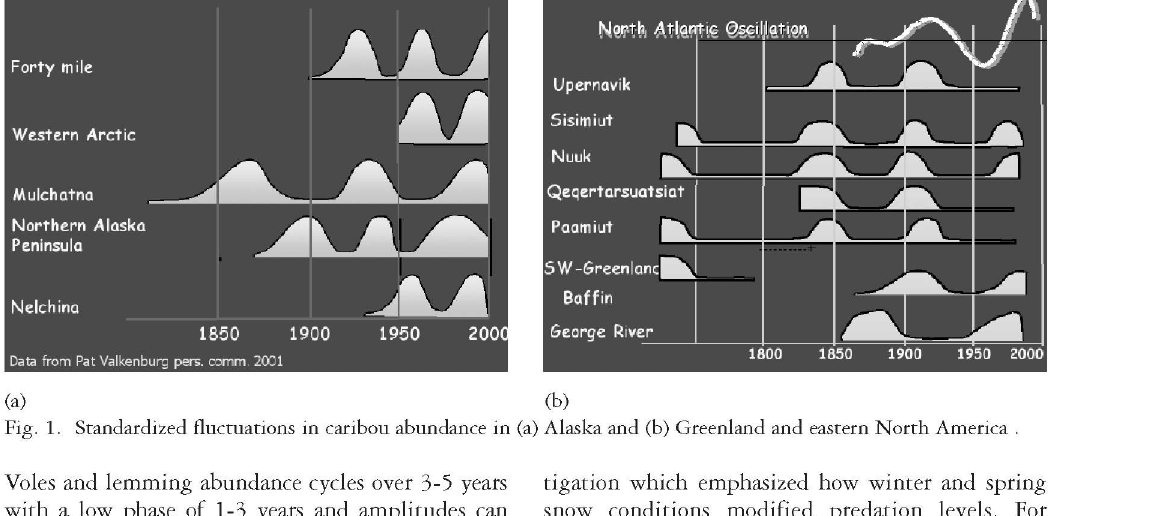
Fig. 1. Standardized fluctuations in caribou abundance in Voles and lemming abundance cycles over 3-5 years with a low phase of 1-3 years and amplitudes can reach 200:1 (Krebs, 1996). Snowshoe hare abun¬ dance in boreal forest cycles at 8-13 years with a mean of 9-10 years. The amplitude is 50-180 depending on latitude. The variability in the cycle length is largely the duration of the low numbers phase. An additional characteristic is that spatial synchrony of peak abundance is regional (voles) or continental (snowshoe hares) (Krebs et al.,